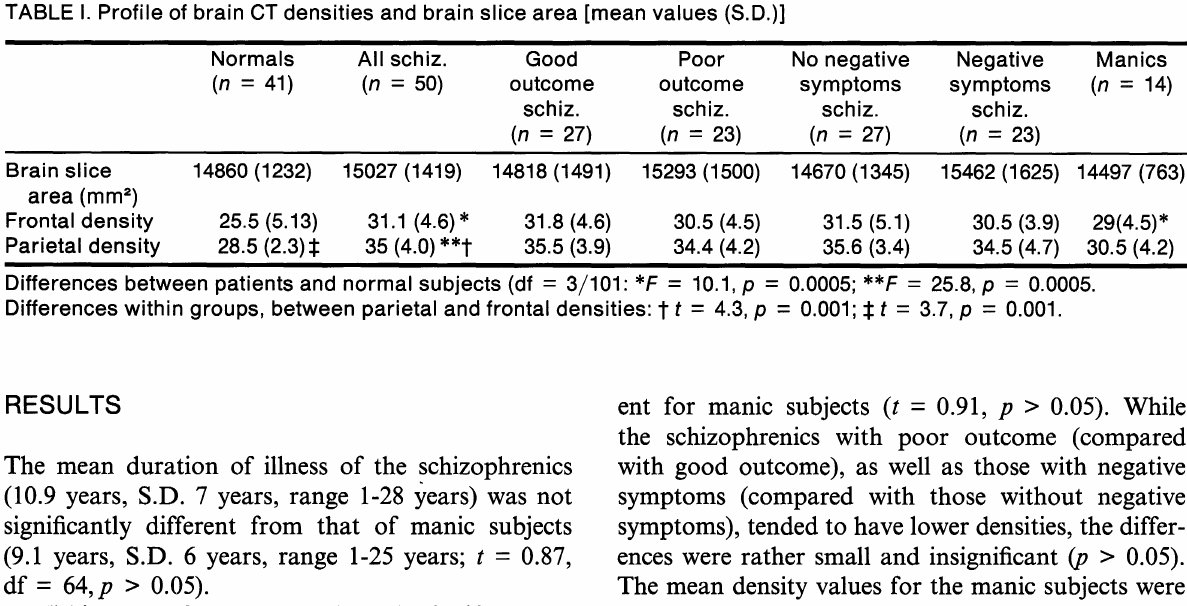
TABLE I. Profile of brain CT densities and brain slice area [mean values (S.D.)]